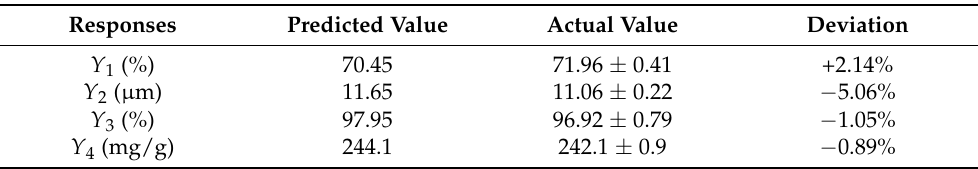
Table 4. Comparison between the predicted value and the actual experimental value at the opti- mized